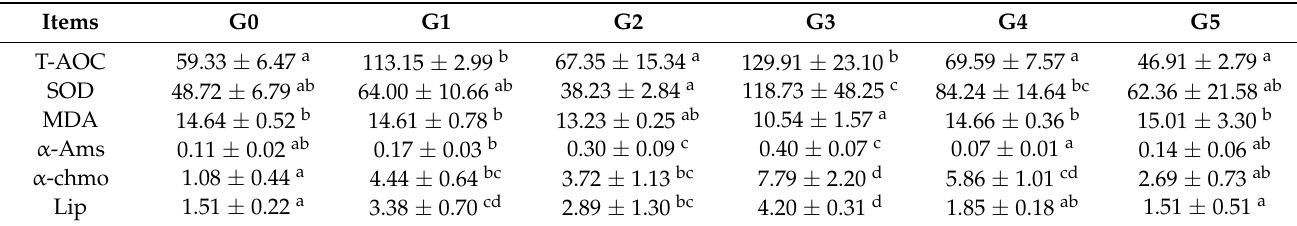
Table 3. AMPs affect intestinal enzyme